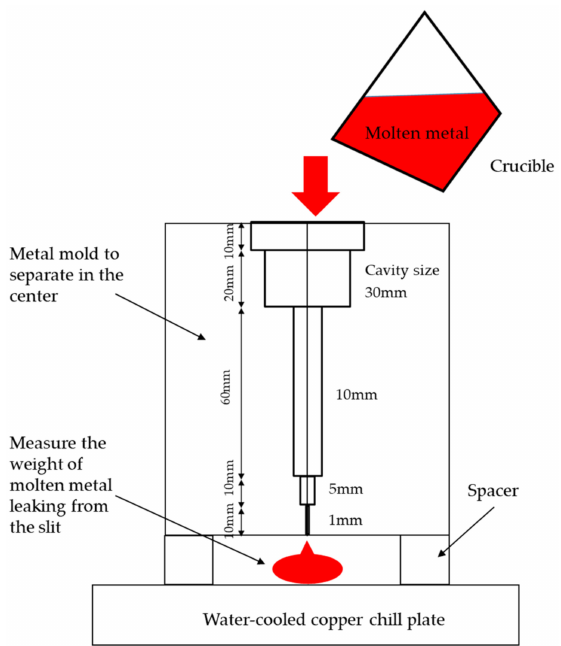
Figure 2. Schematic of the experimental procedure used for comparing the fluidity of the molten